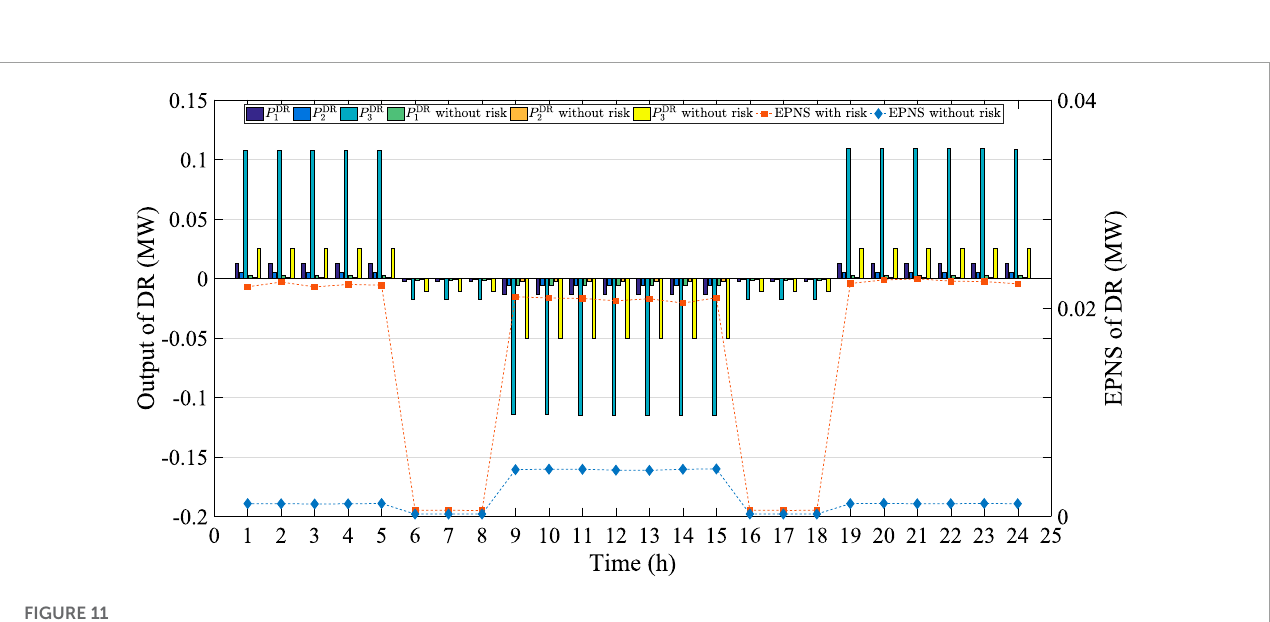
FIGURE 11 The hourly power and EPNS of DR with and without uncertain